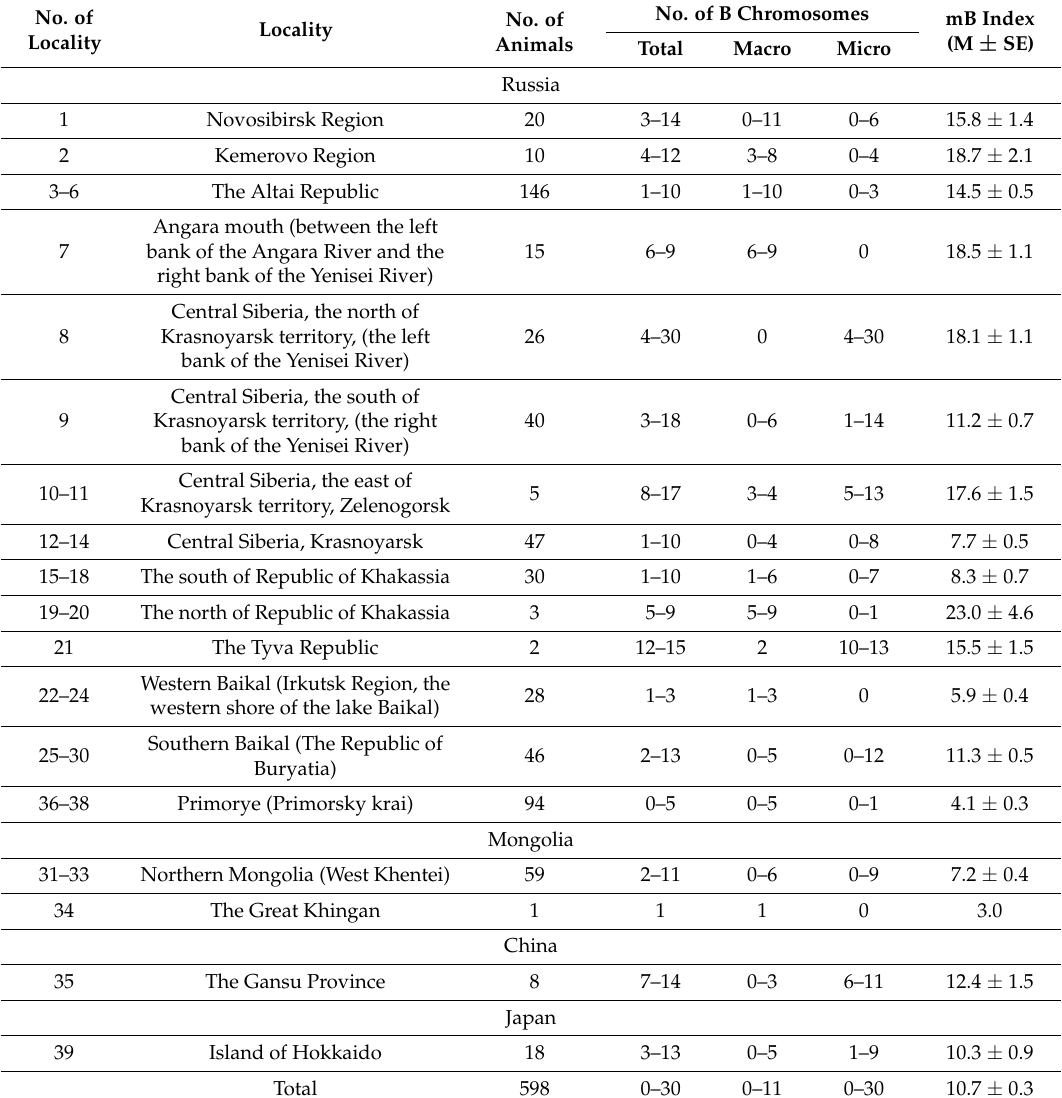
Table 1. B chromosome characteristics in the Korean field mouse Apodemus peninsulae Thomas, from different localities. For geographical map of localities see Figure 1. mB Index: mass quantity of B